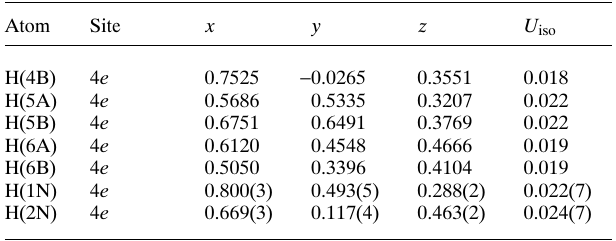
Table 2. Atomic coordinates and displacement parameters (in Å 2 )